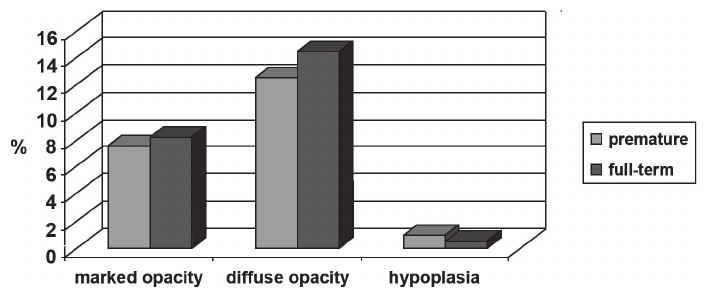
Figure 2 - Percentage of marked opacity, diffuse opacity and hypoplasia in permanent